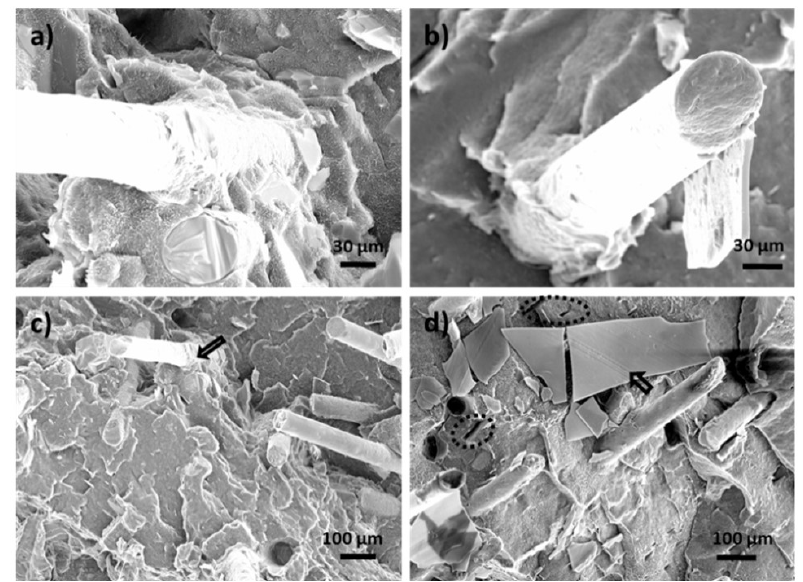
Figure 5. SEM micrograph of fractured surfaces of composites with combined fillers. Upper two charts ( a , b ) 10 wt % filer(talc/glass fiber = 1:2); and Lower two charts ( c , d ) 30 wt % filler (talc/glass fiber = 1:2).